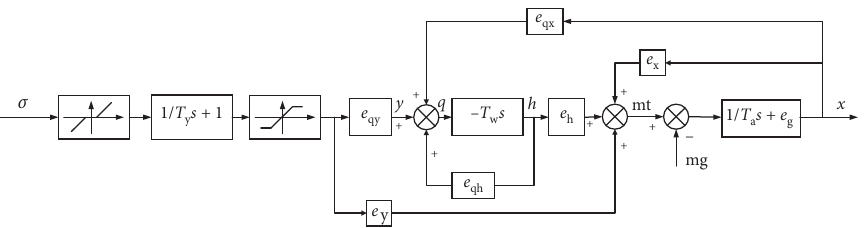
Figure 2: The system block diagram of hydraulic turbine unit.